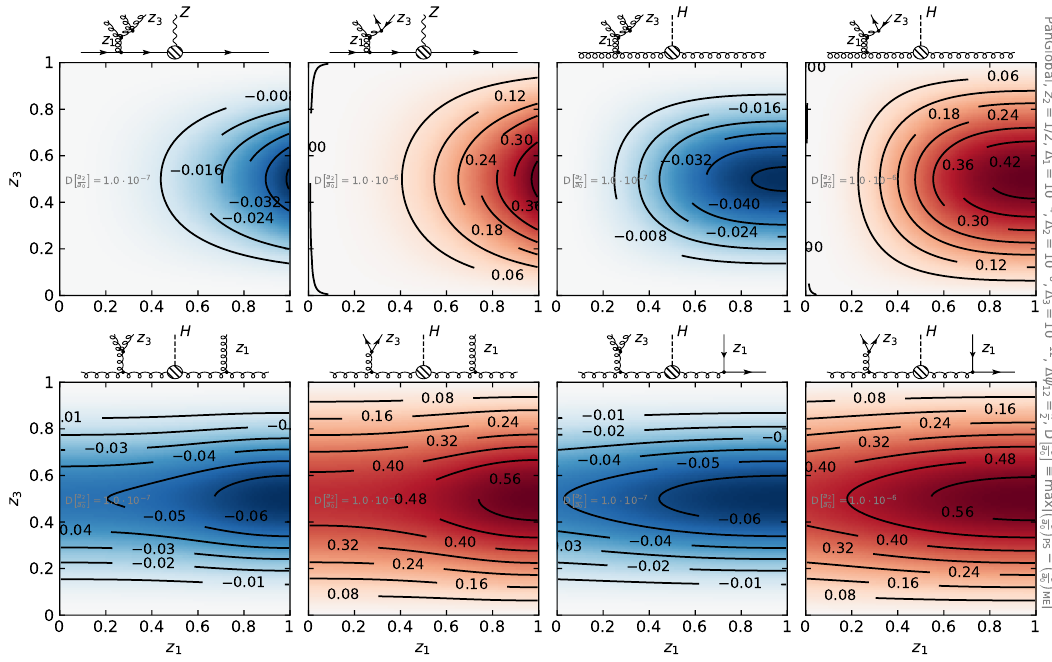
Figure 15. Same as figure 14 but with ∆ ψ 12 = π/ 2